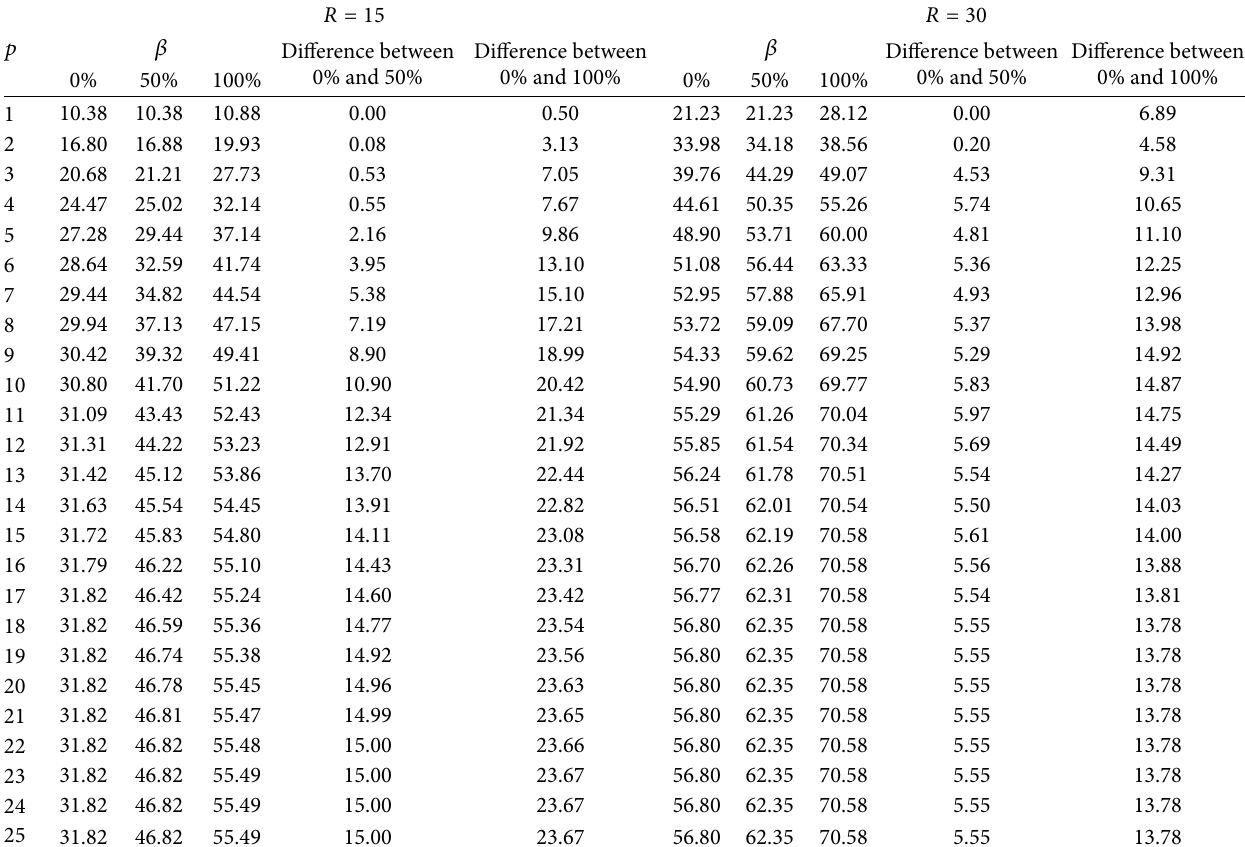
Table 7: Comparisons of the optimal coverages of no-detour ( when 푅 = 15, 30